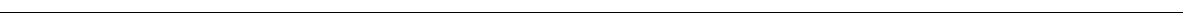
Fig. 5 Subtype-speci fi c chromatin landscapes de fi ne adult neurons. a RNA-seq: Volcano plot showing differential gene expression between SER and mDA neurons. Differentially expressed genes with an adjusted p -value < 0.05 obtained by Wald test are shown. b Volcano plot as in a , differentially expressed and H3K27me3 and/or H3K9me3-marked genes colored according to: marked in mDA – pink, marked in SER – green, and marked in both mDA and SER – gray. c Gene ontology (GO) of selected ( − log10 (adj p -value), Fisher ’ s exact test) biological processes for upregulated genes in mDA relative to SER ( n = 272). d As in b for downregulated genes in mDA relative to SER ( n = 160). e ChIP-seq heatmaps showing the abundance of H3K27me3, H3K4me3, and H3K9me3 as RPKMs ± 10 kb around TSS of genes upregulated in mDA relative to SER neurons and associated with a chromatin state containing